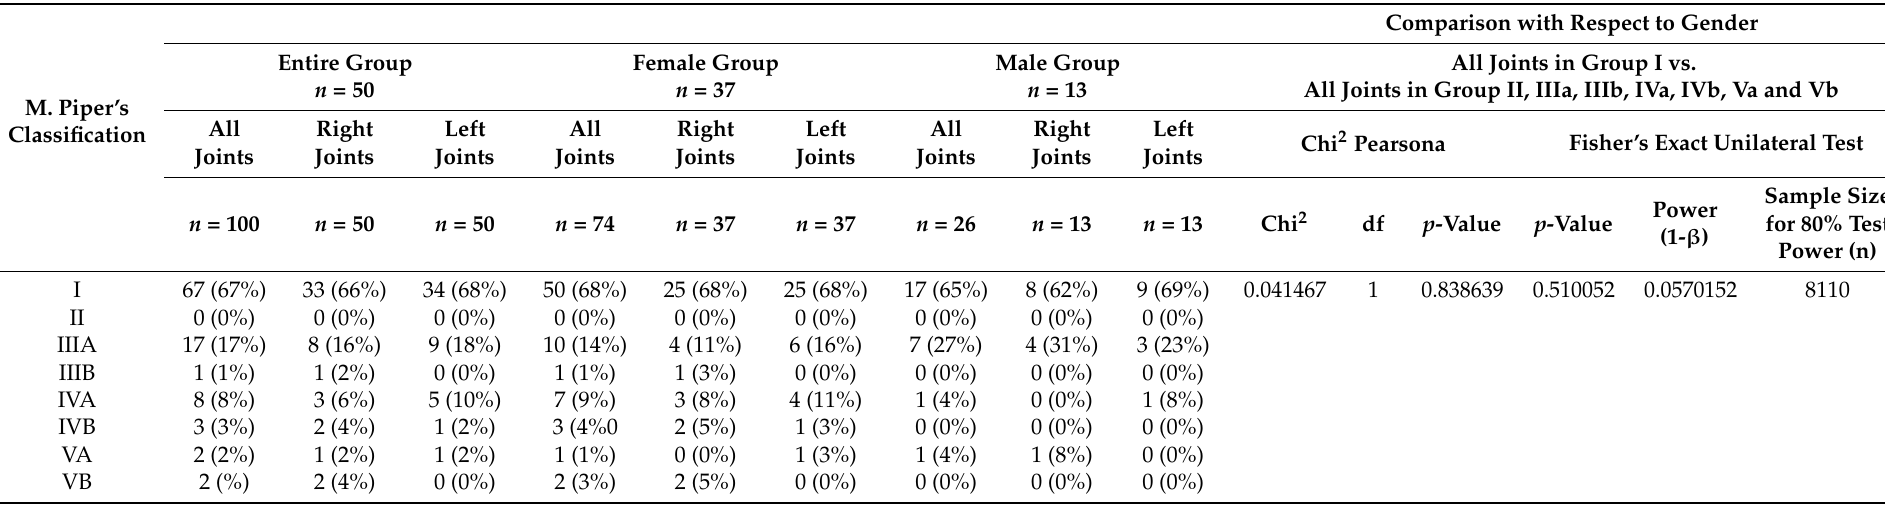
% percentage within column (% all joints; % right joints; % left joints). M. Piper’s classification of TMJ damage [40,41] I—Normal; II—Ligaments or cartilage damage; IIIA—Partial disc subluxation, with reduction; IIIB—Partial disc subluxation, non-reducing; IVA—Complete disc dislocation, with reduction; IVB—Complete disc dislocation, non-reducing; VA—No disc, Bone to bone—Adapting; VB—No disc and Bone to